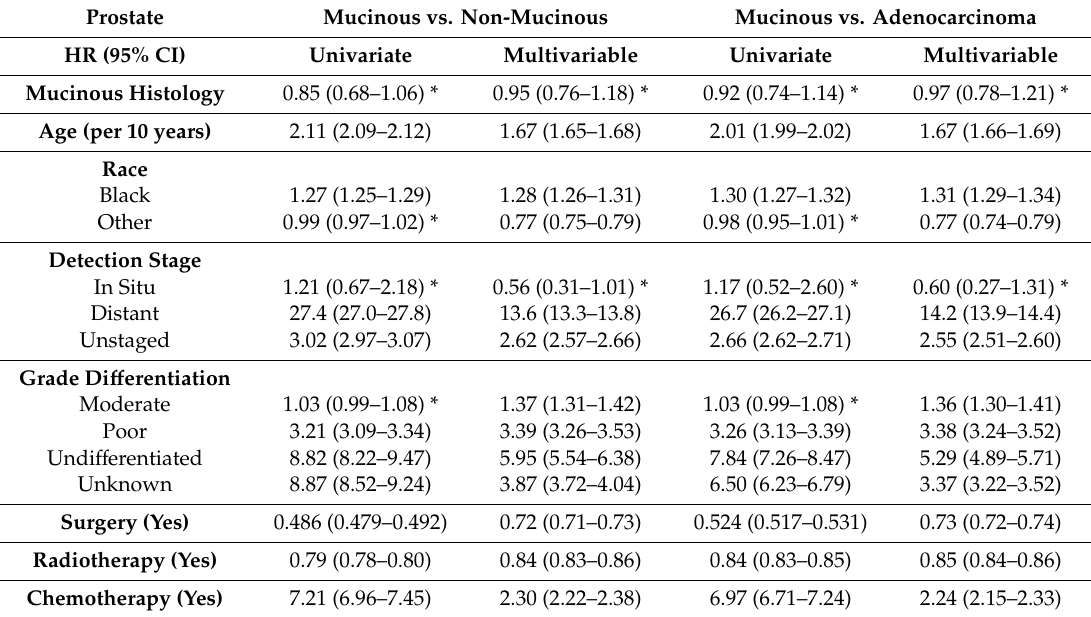
Table 22. Derived univariate and multivariable Cox-proportional hazard ratios (HR) of mortality for prostate